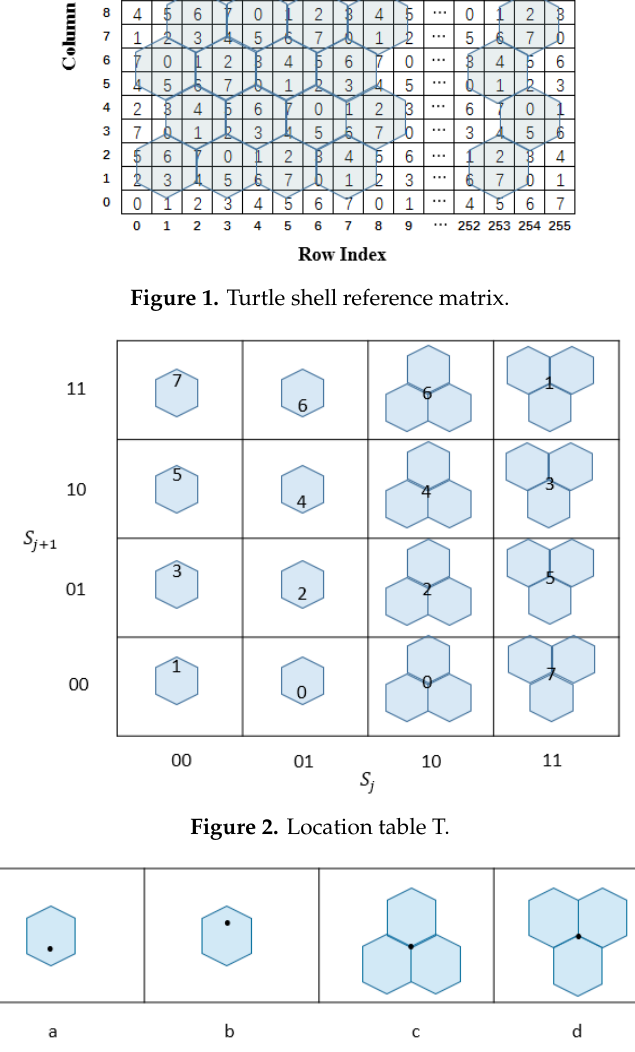
Figure 3. Four locations of elements in M.